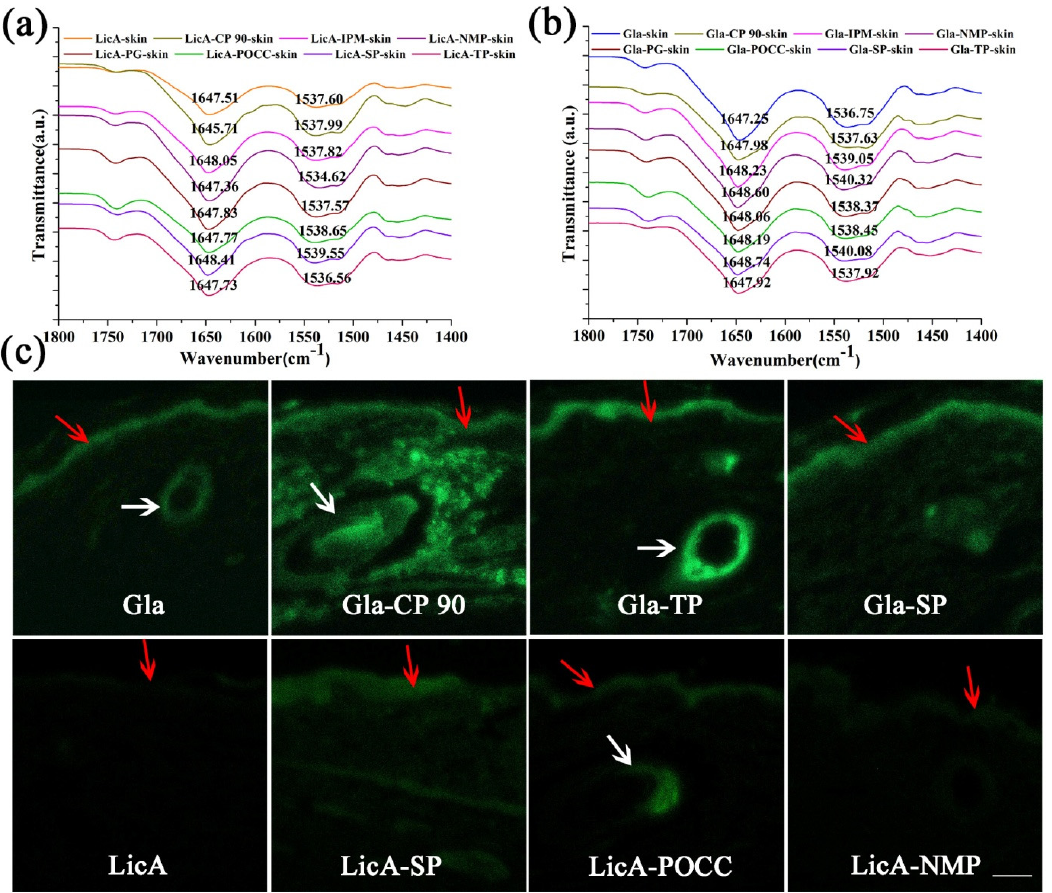
Figure 7. ( a ) FT-IR spectra (C = O group) of LicA–enhancers–skin systems; ( b ) FT-IR spectra (C = O group) of Gla–enhancers–skin systems; ( c ) CLSM images of the penetration depth and fluorescence intensity LicA and C6 in porcine skin treated withenhancers (Bar = 100 μ m, the red arrows and white arrows represent the SC and hair follicles of the skin,